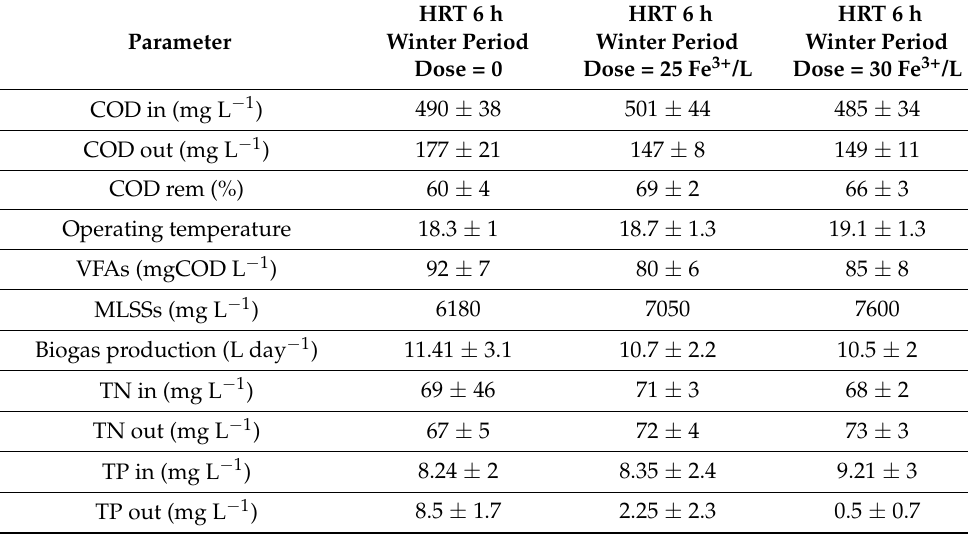
Table 6. Average concentrations ( ± SD) for influent and effluent quality parameters with and without FeCl 3